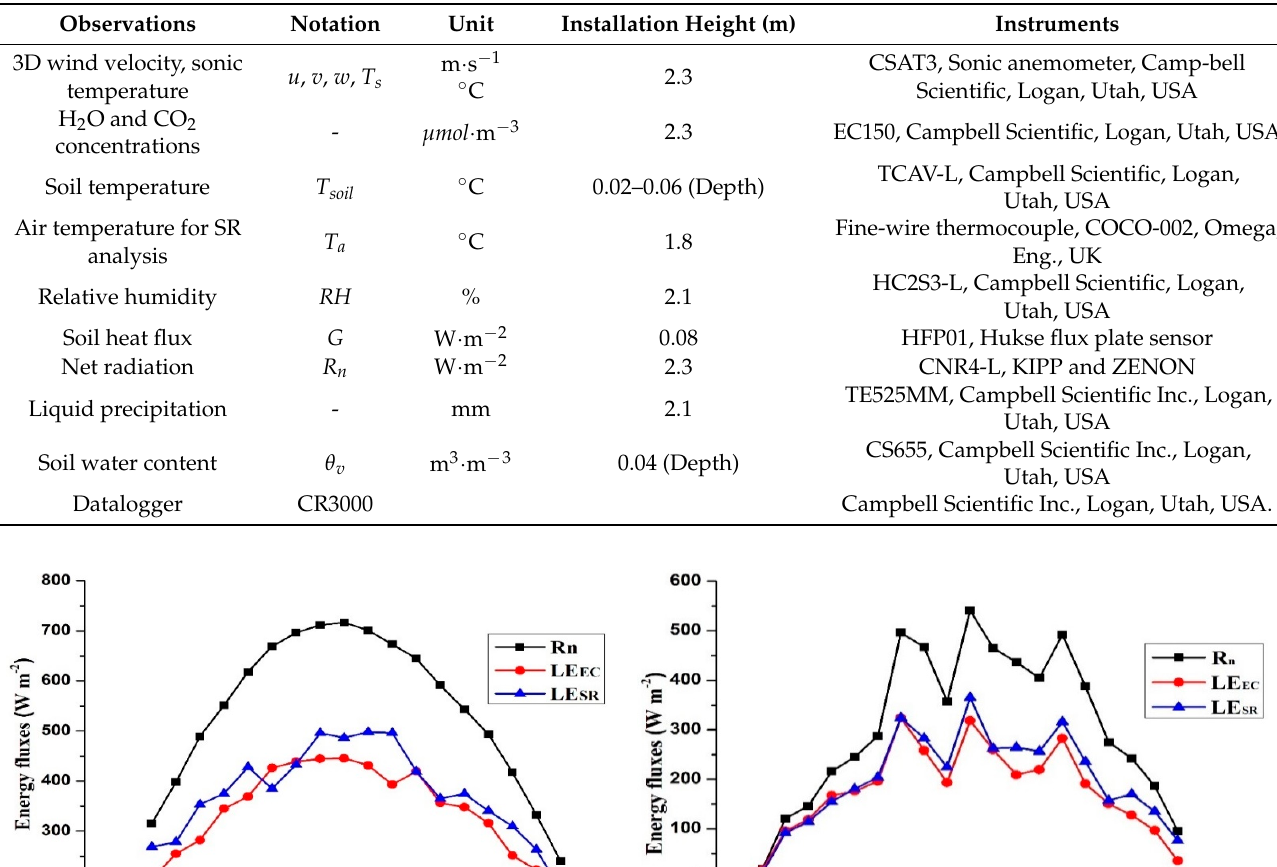
Table 2. Experiment instruments and installation.